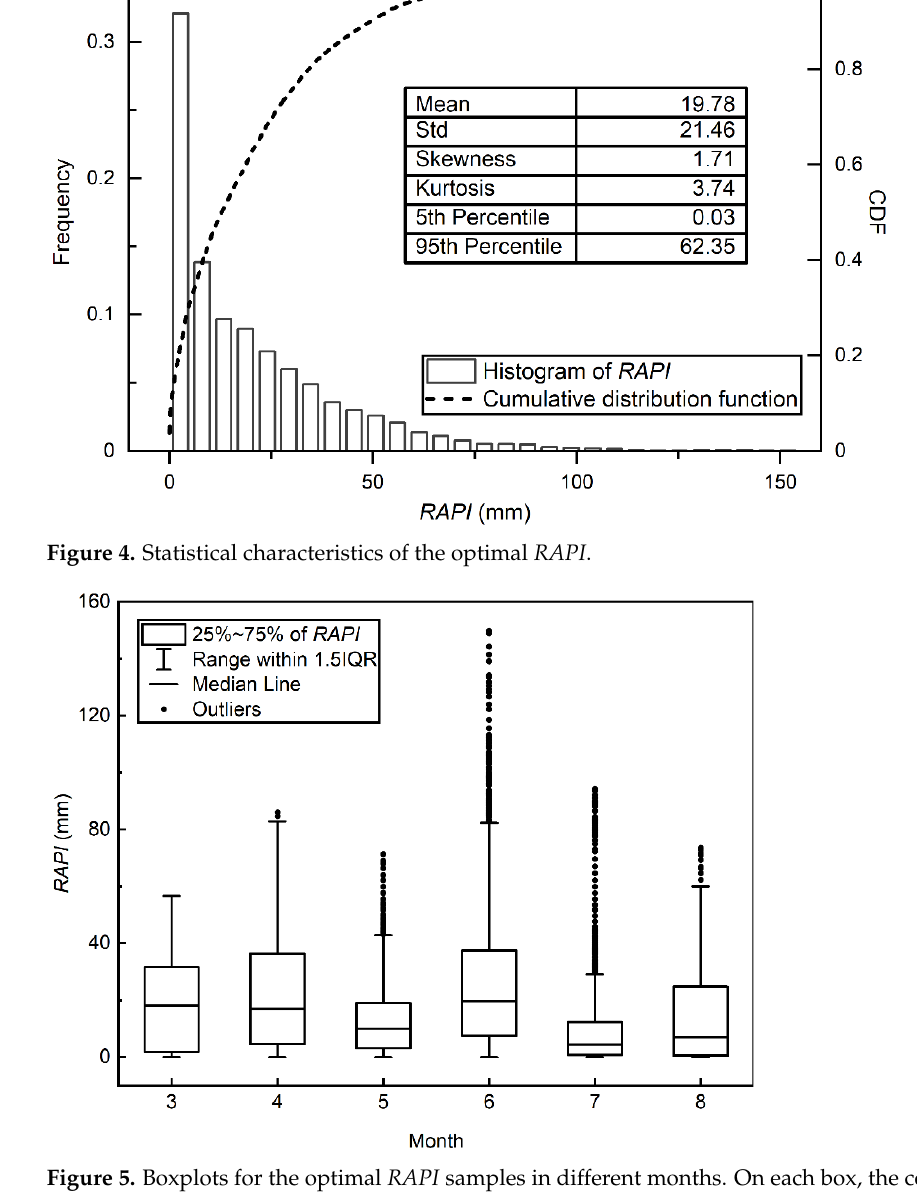
Figure 5. Boxplots for the optimal RAPI samples in different months. On each box, the central mark indicates the median, and the bottom and top edges of the box indicate the 25th and 75th percentiles, respectively. Outliers are plotted using solid points.